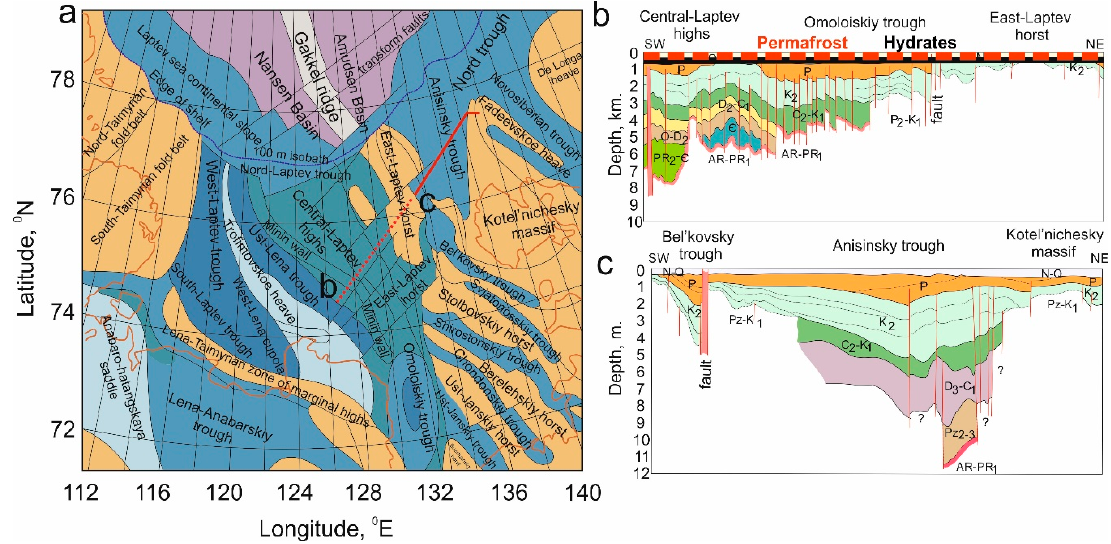
Figure 1. Maps of the Arctic Ocean (AO) highlighting specific features of the East Siberian Arctic Shelf (ESAS): ( a ) Predicted areas of hydrate deposits over the AO, including the shallow ESAS, shown in blue (after [14]); ( b ) bathymetry of the AO; red color refers to depth <50 m [24]. As seen from the panels, the ESAS represents a major fraction of the AO shallow continental shelf.